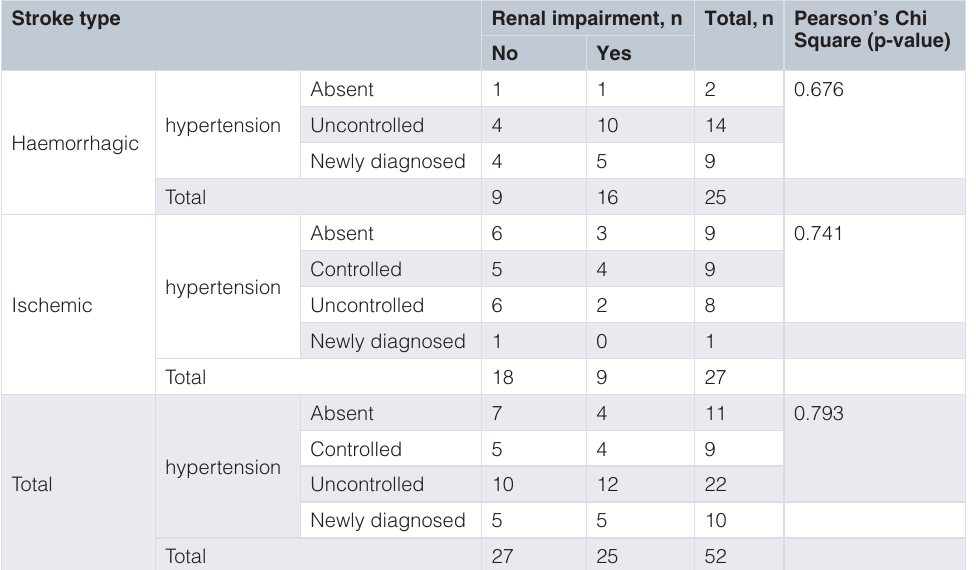
Table 1. Association between hypertension and renal impairment in patients who had haemorrhagic or ischemic stroke. Stroke